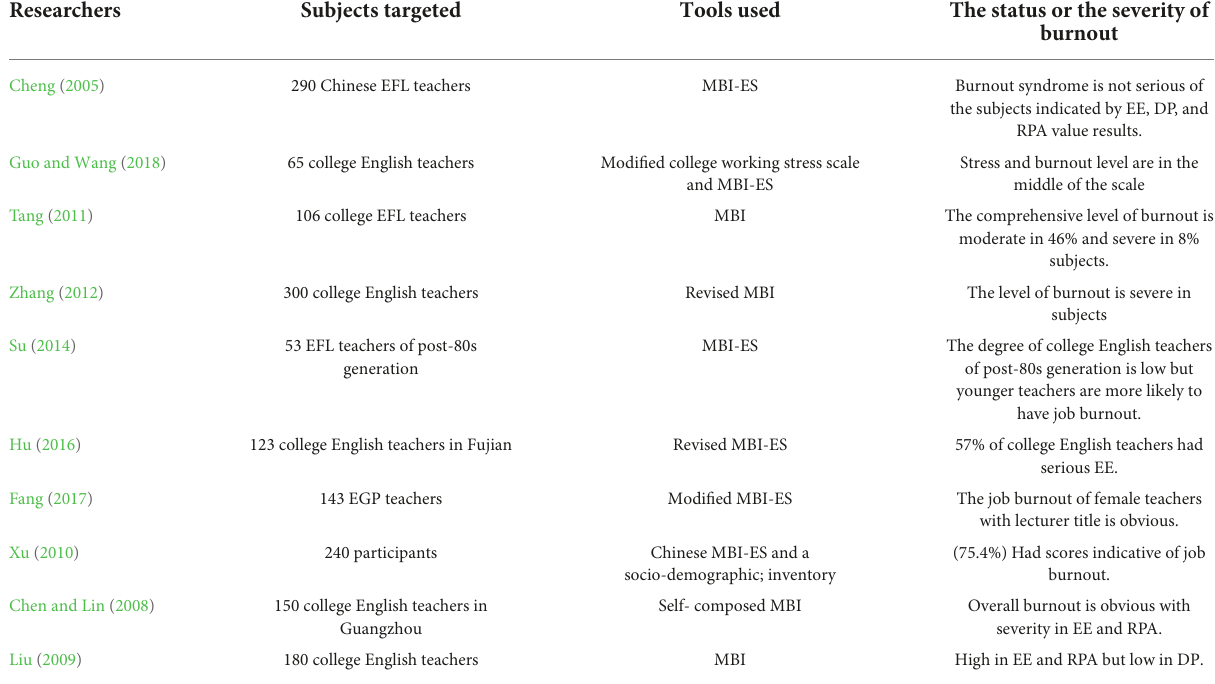
TABLE 1 Main results of burnout from 10